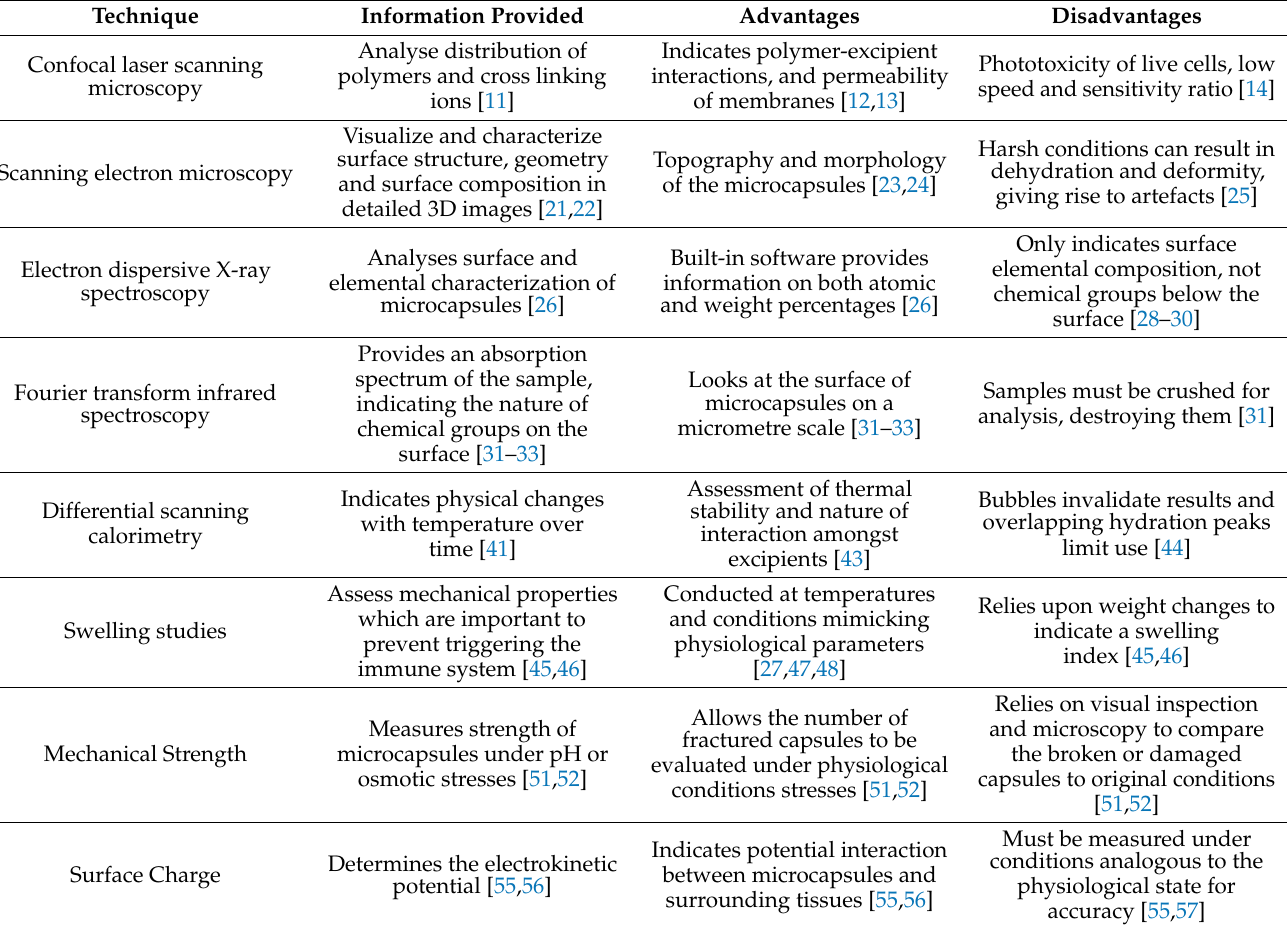
Table 1. Mechanisms, information provided by, advantages and disadvantages of microcapsule analysis techniques.